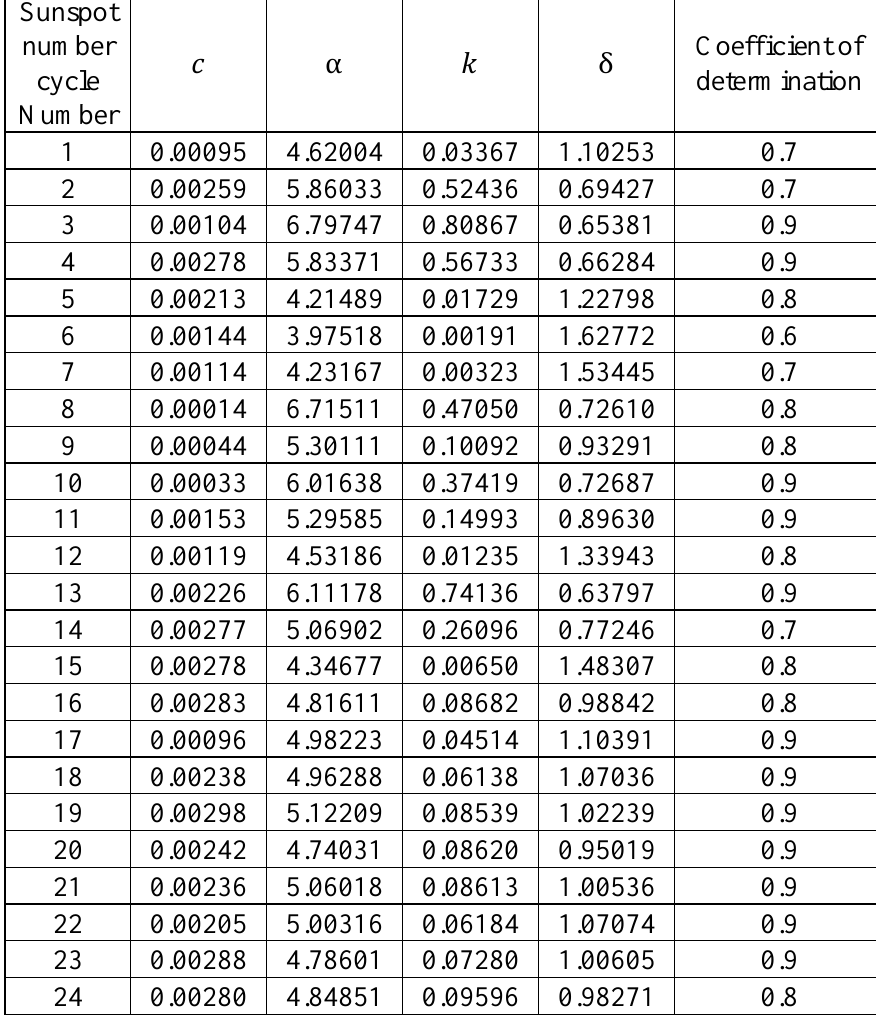
Table 2. The estimated model parameters for sunspot number cycles 1 to 24.